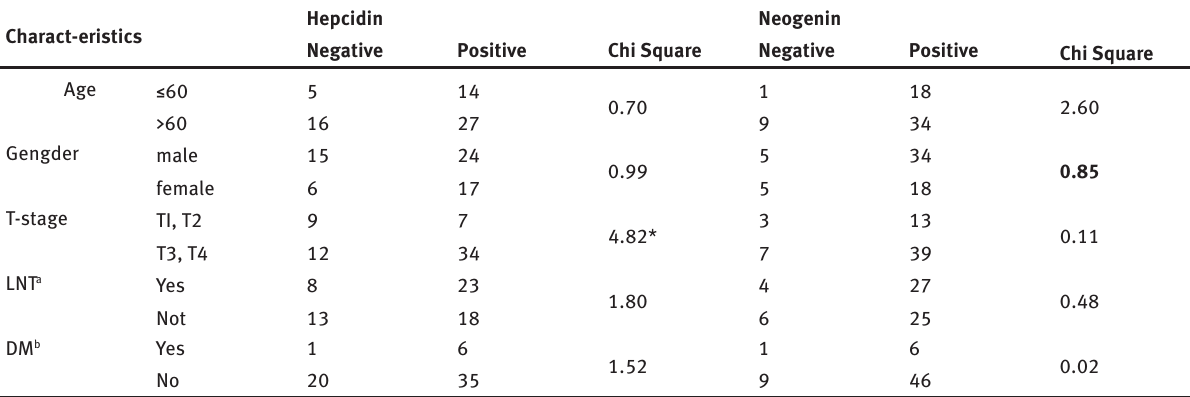
Table 1: Expressions of Hepcidin and Neogenin in colorectal cancer and their association with clinical characteristics.